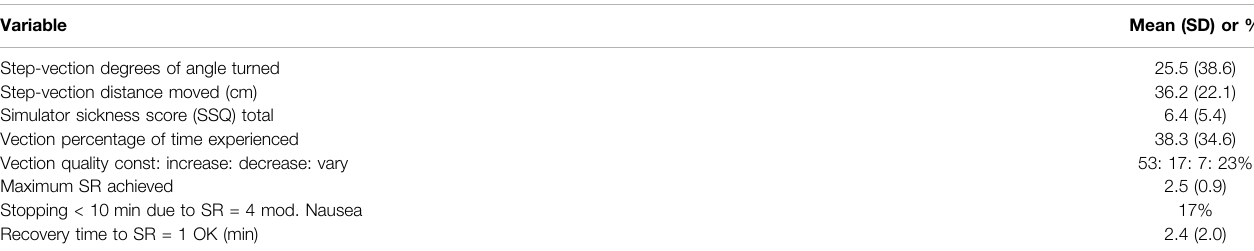
TABLE 3 | Stepping-vection and visual stimulus experiments: descriptive